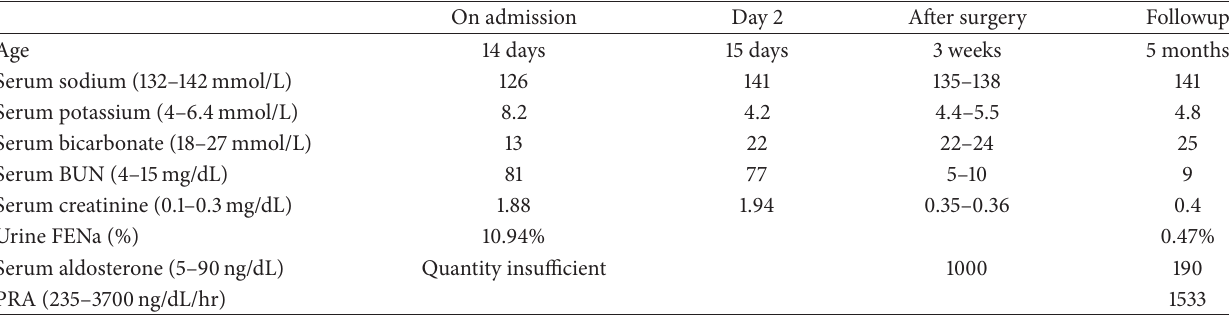
Table 1: The biochemical data of the patient.